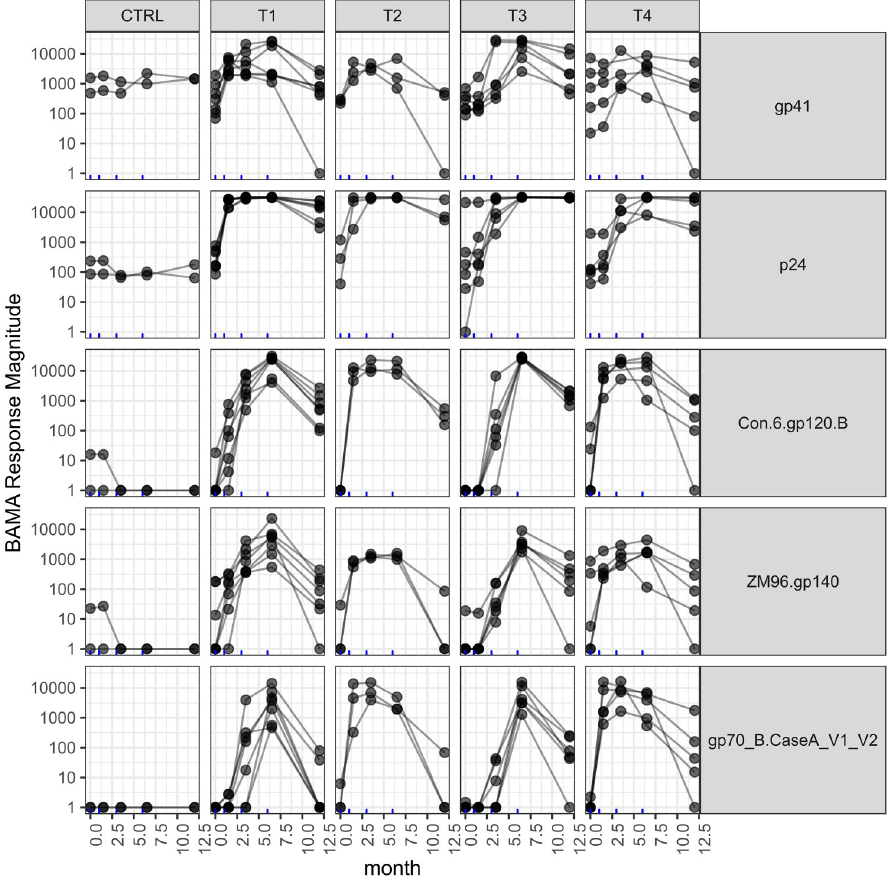
Fig 1. Concentration of antibodies among study participants whose gut microbiota was characterized through the BAMA assay. Participants were vaccinated at four time-points, indicated by blue tick marks along x axis, following the regimen described in the